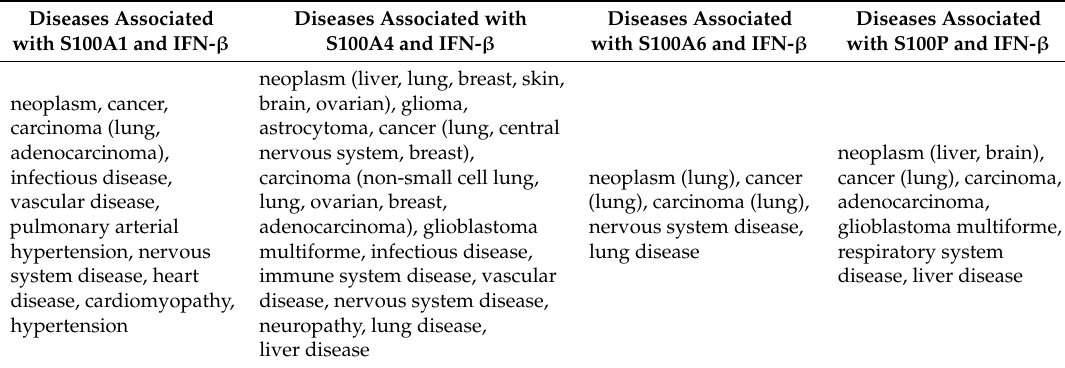
Table 2. List of the human diseases associated with IFN- β and S100A1, S100A4, S100A6 or S100P protein, according to Open Targets Platform (https: // www.opentargets.org). The association scores for IFN- β and S100 exceed